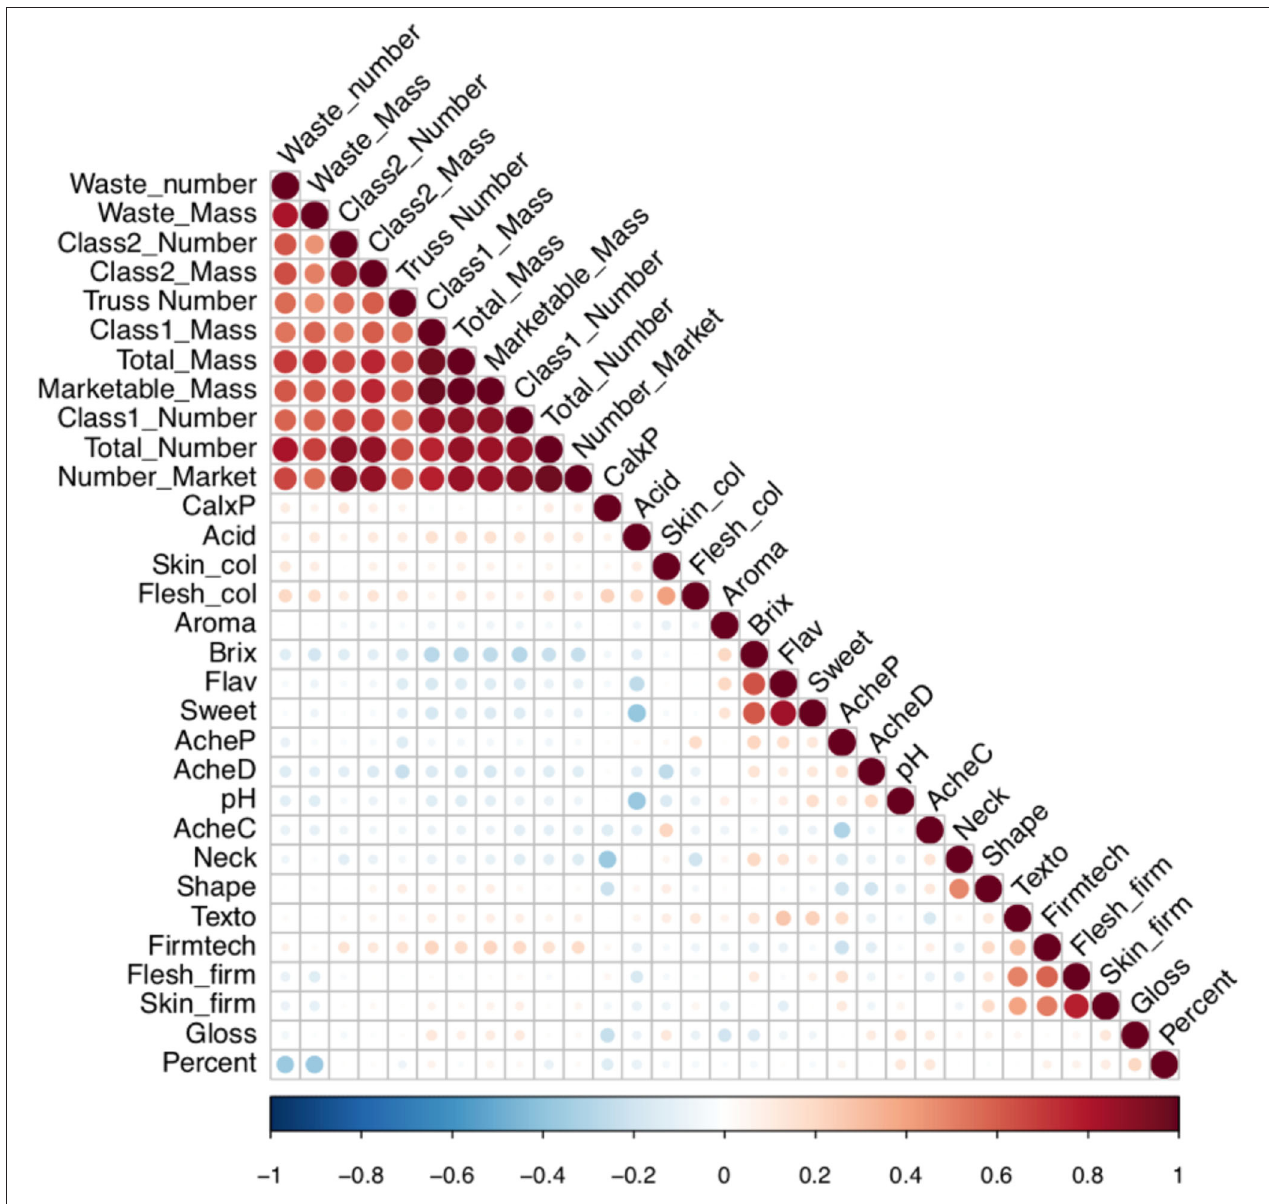
FIGURE 4 | Correlation matrix between the fruit quality and yield traits within the multi-parental strawberry population. The strength of colour denotes the magnitude and direction of the correlation coefficient. The size of the circle denotes the significance value. CalxP, calyx position; Skin_col, skin colour; Flesh_col, flesh colour. Acid, acid perception; AcheC, achene colour; Neck, neck position; Shape, height:width; Texto, texture rating overall; Fimtech, Firmness, instrument; Flesh_firm, flesh firmness manual; Skin.firm, skin firmness; Gloss, glossiness; Percent, percentage of marketable fruit; AcheP, achene position; AcheD, achene density; Aroma, aromatics; Brix, total soluble sugars; Flav, flavour perception; Sweet, sweetness